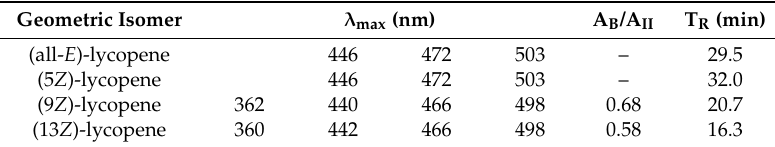
Table 3. On-line spectral characteristics and retention times, determined by diode-array detection (in the range of 200–600 nm) using HPLC separation with a C30 reversed-phase column (see Graham et al. [18] for further details). λ max —wavelength of the main absorption bands; A B /A II —the relative intensities of the heights of the cis -peak and the middle absorption band ( λ max ); T R —the retention time. Geometric Isomer λ max (nm) A B /A II T R